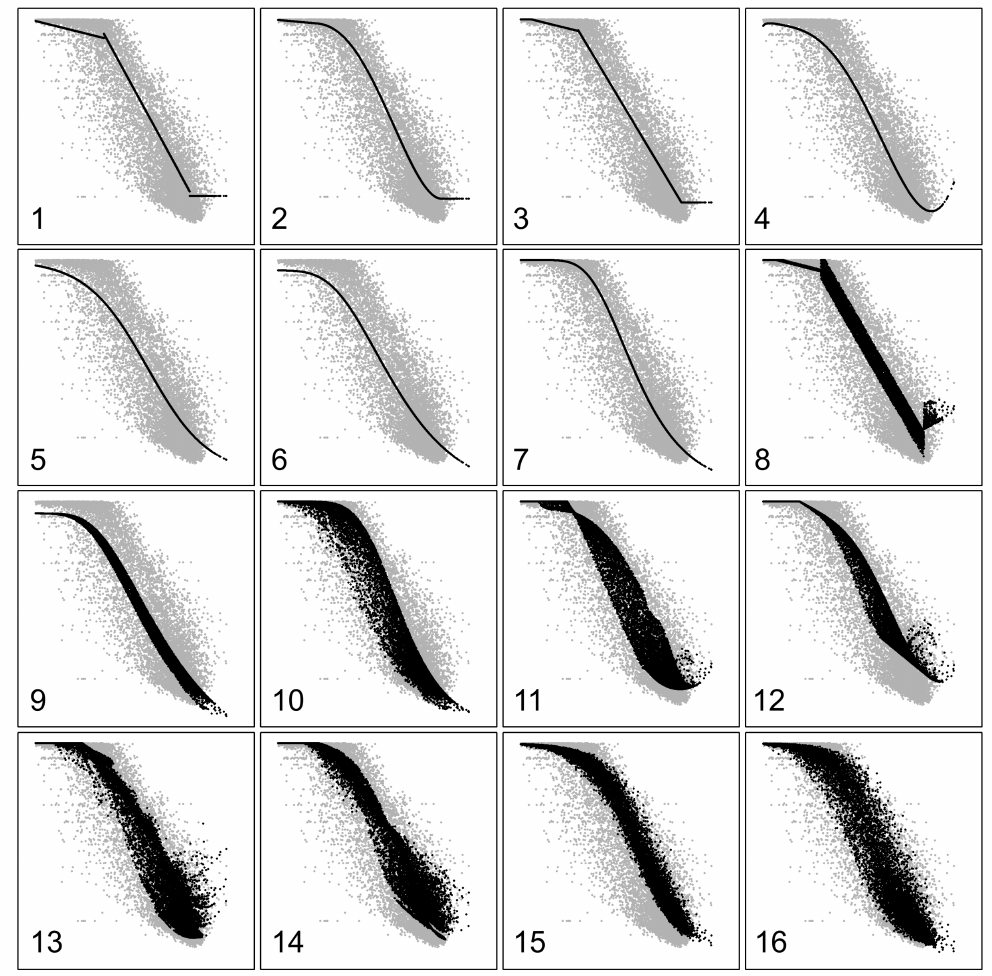
Figure 3. Scatterplots of k t vs. k d for the experimental data (grey dots) and according to the different decomposition models (black dots). See Table 1 for the numbers associated with the models. The axes are the same as in Figure 2 (axes labels not reported for the sake of